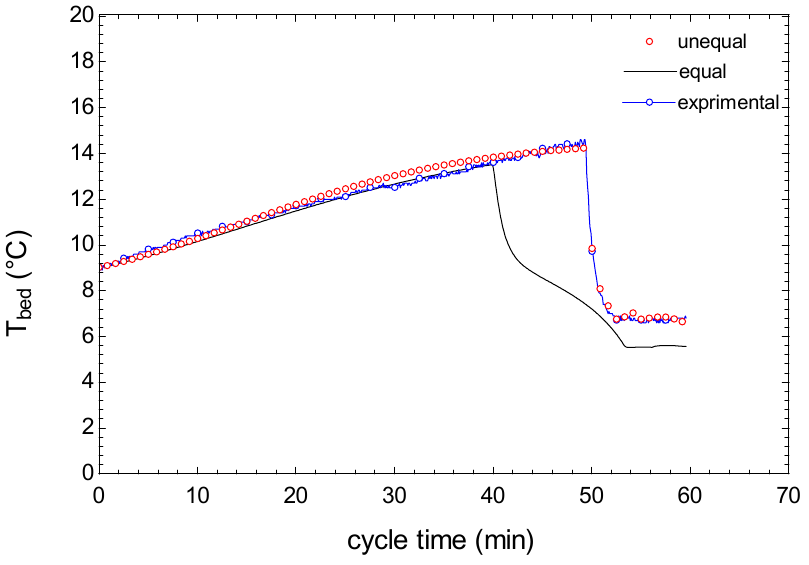
Figure 8. Temperature profile of the evaporator.